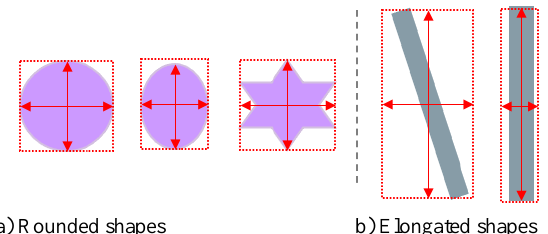
Figure 3. Rounded shapes (length ~ width) for hotspots and elongated shapes for (length >> width) for movement trajectories